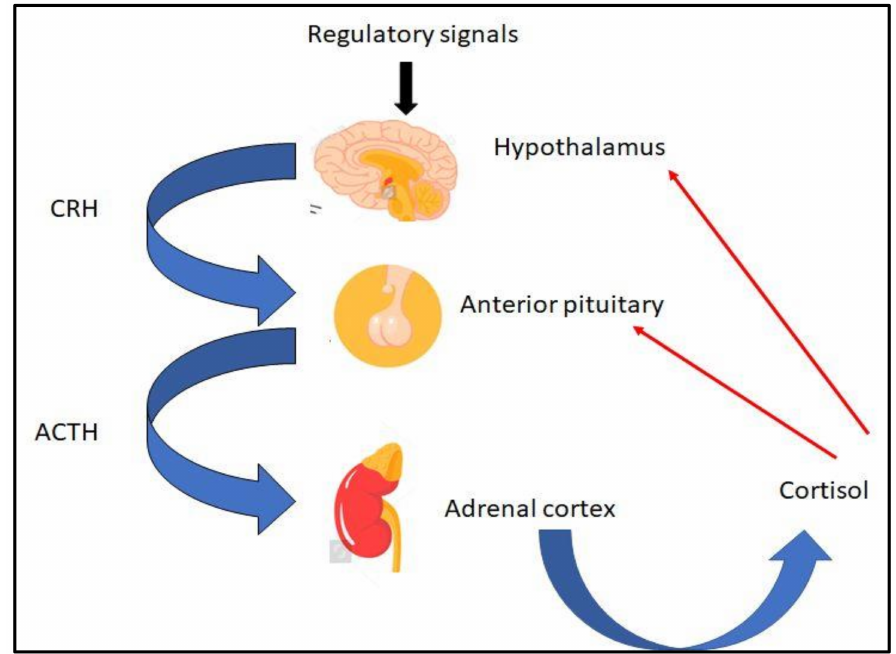
Figure 1. The normal stress response. Cortisol production in the adrenals is regulated by the secretion of ACTH from the pituitary gland, which depends primarily on pulses of CRH, secreted by the hypothalamus. Cortisol then inhibits CRH and ACTH secretion. ACTH: adrenocorticotrophin; CRH: corticotropin-releasing